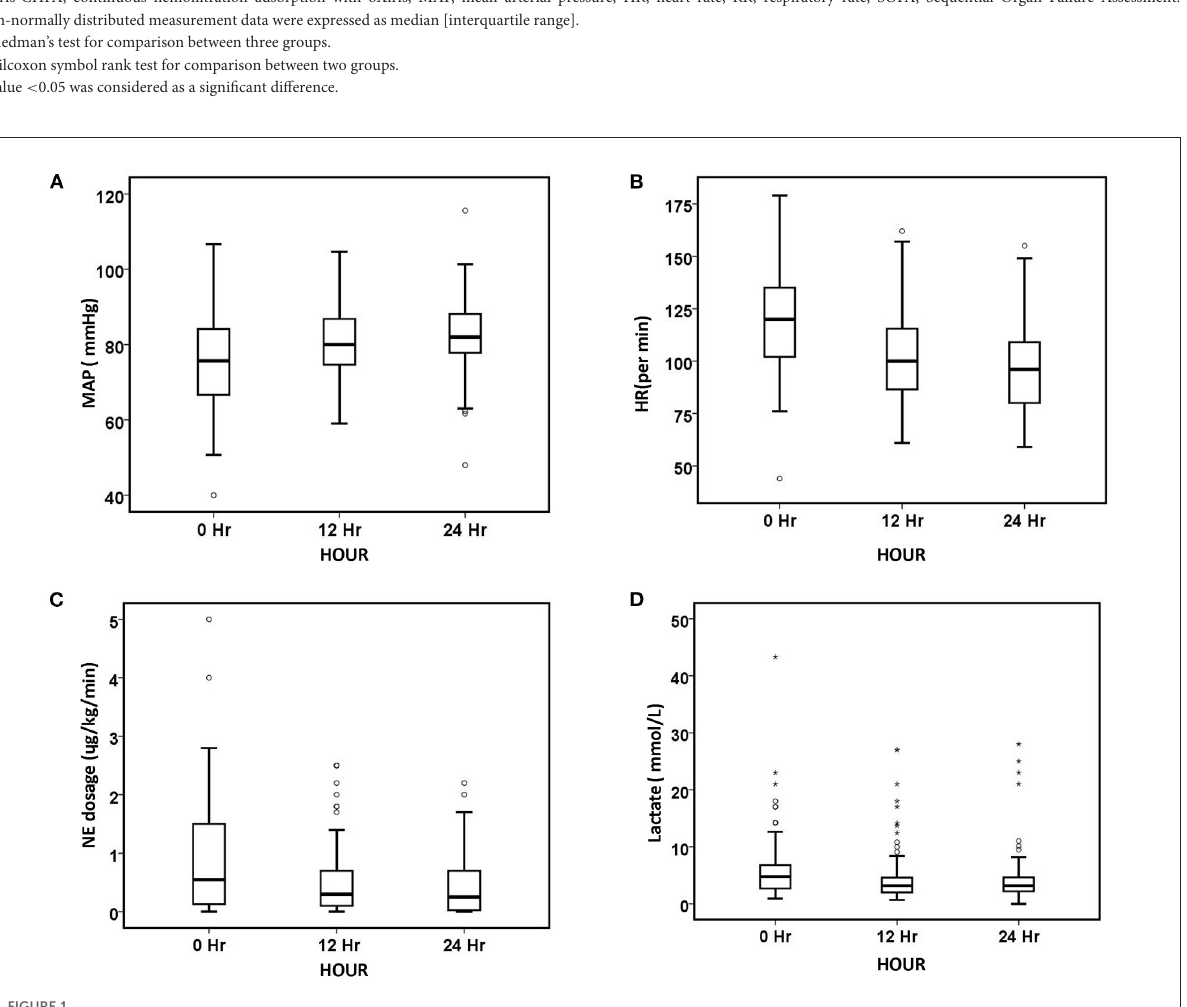
SOFA score ( p = 0.004), and age ( p = 0.011) were independently associated with ICU mortality rate. For every 1-unit increase in pre-treatment SOFA score, the risk of death increased by